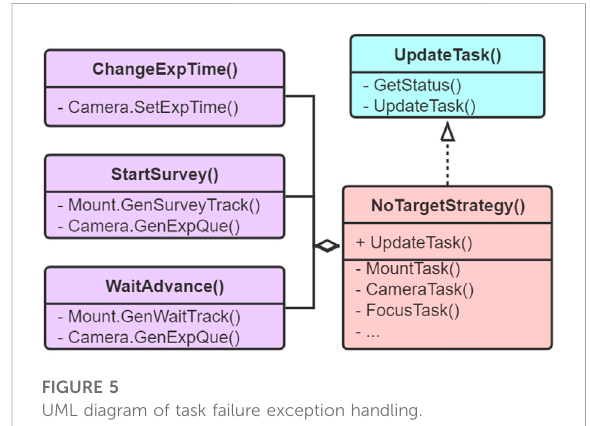
FIGURE 5 UML diagram of task failure exception